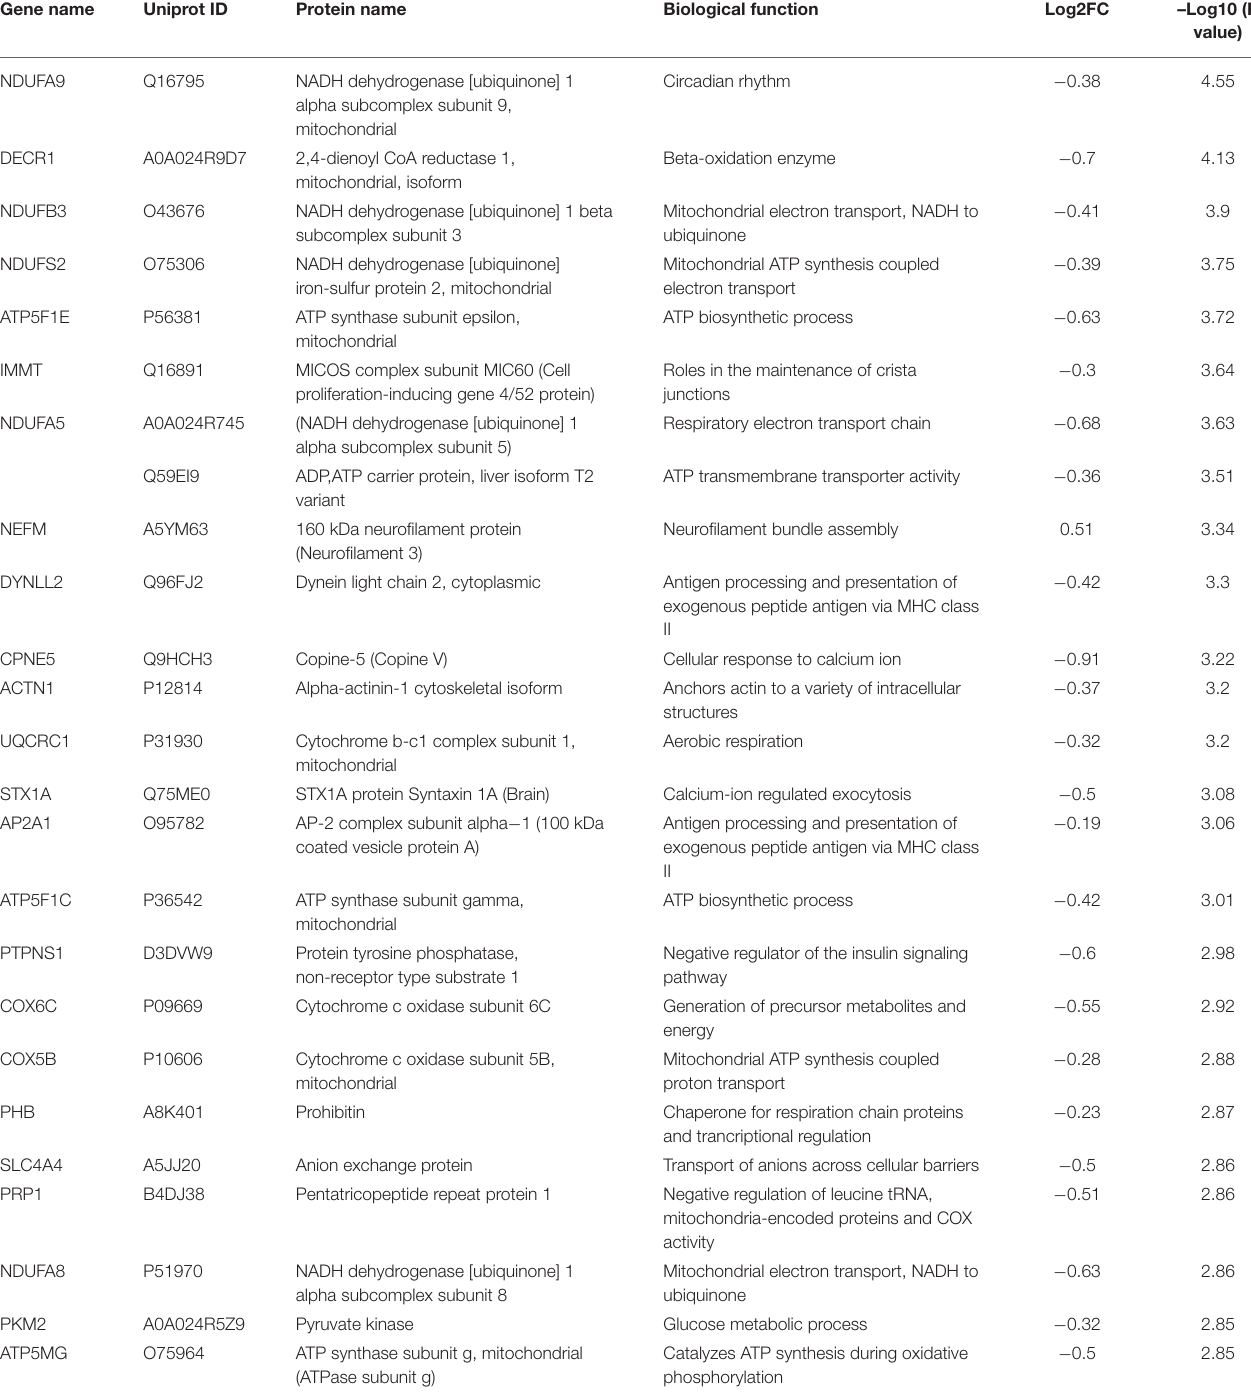
TABLE 4 | List of Top 25 proteins significantly regulated in the inferior frontal gyrus cerebrovasculature of high CAA vs. aged-matched control